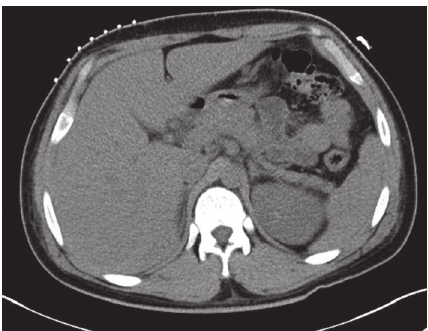
Figure 5: C.T. abdomen after